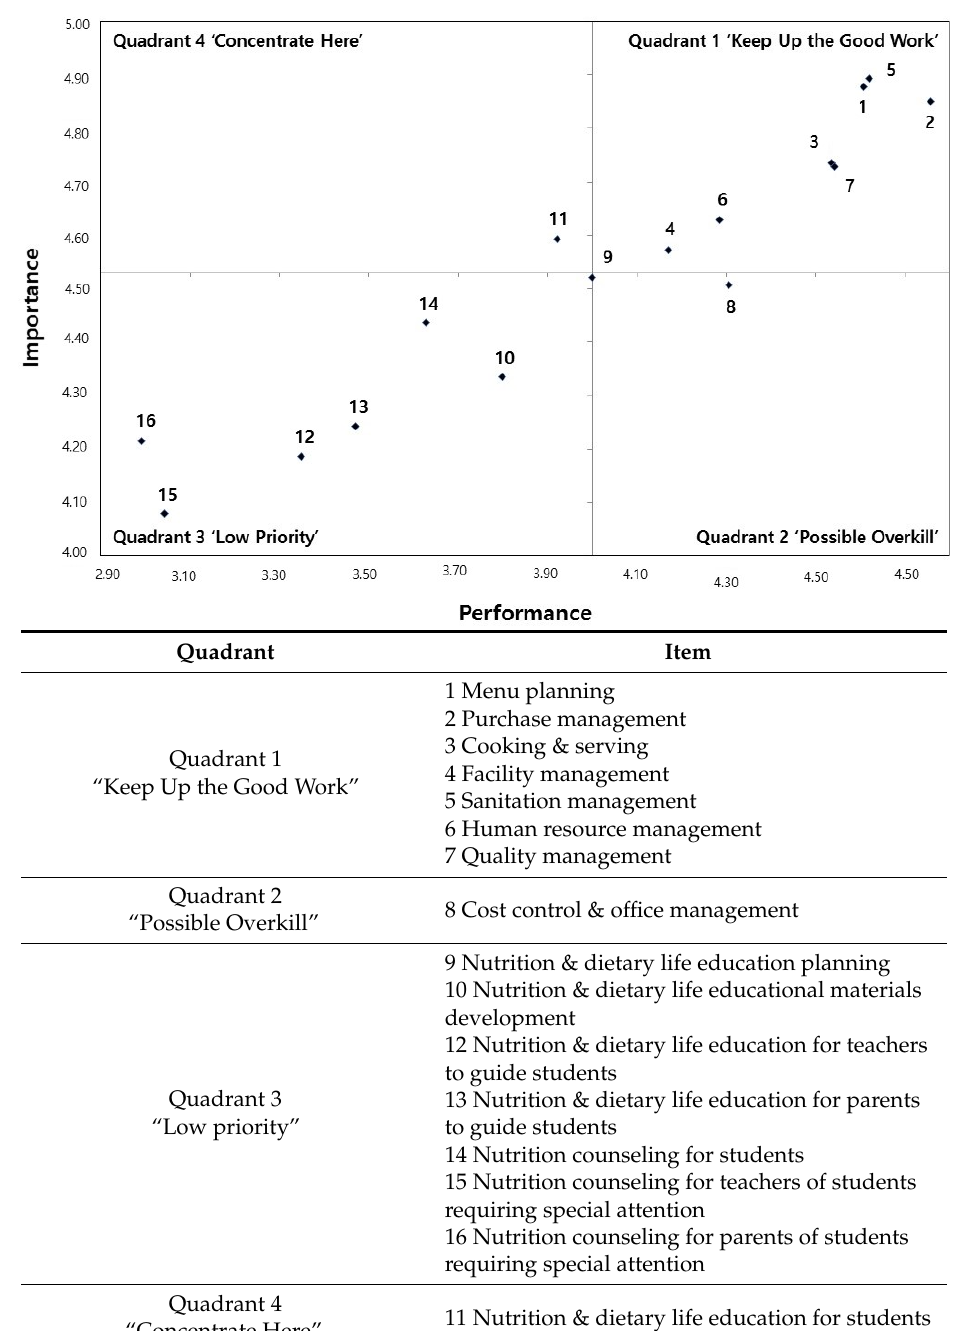
Figure 1. Importance–performance analysis of nutrition teachers’ and dietitians’ tasks.